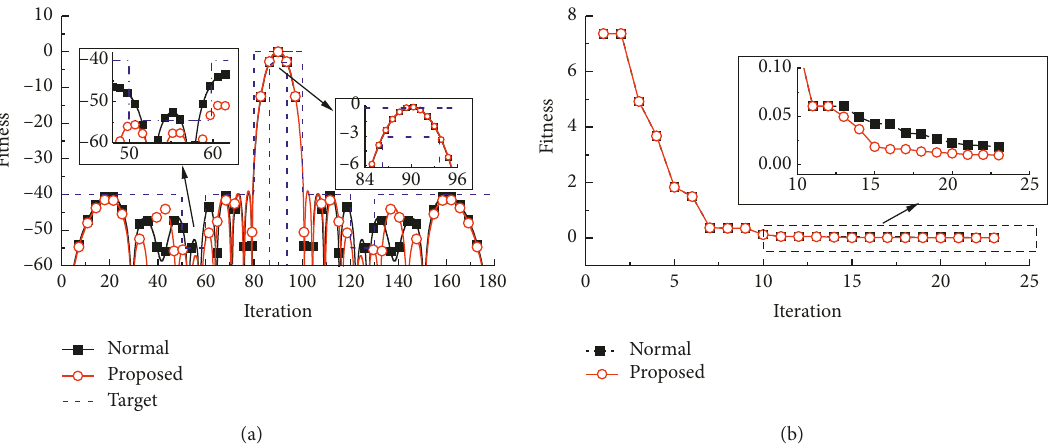
Figure 5: Comparisons of patterns and convergence curves between the normal method and proposed Taguchi method. (a) Patterns. (b) Convergence